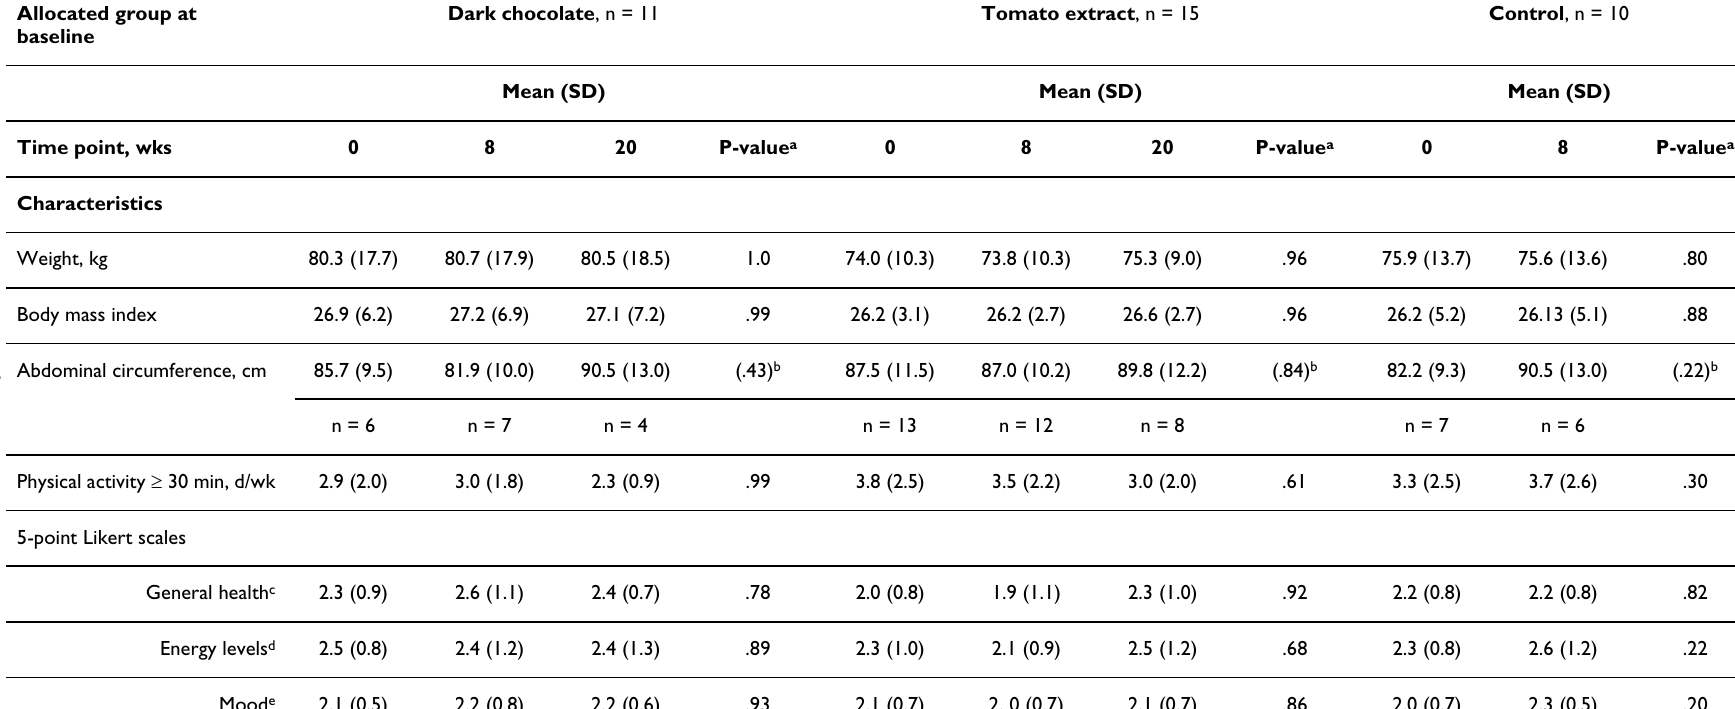
Table 3: Changes over time in selected characteristics of